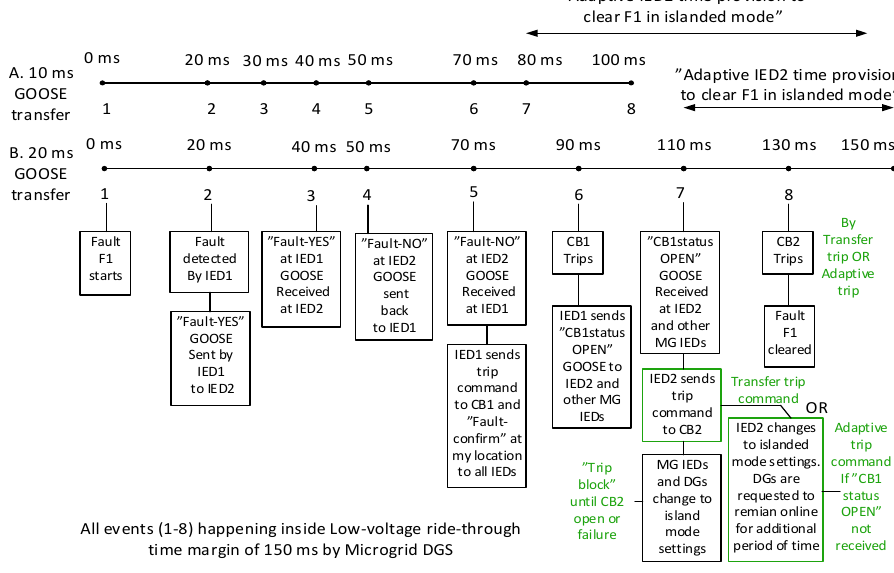
Figure 6. Fault F1 clearance time with 10-ms and 20-ms GOOSE message transfer delays (CB2 can trip by transfer trip GOOSE from IED1 or by adaptive IED2 using islanded mode settings).